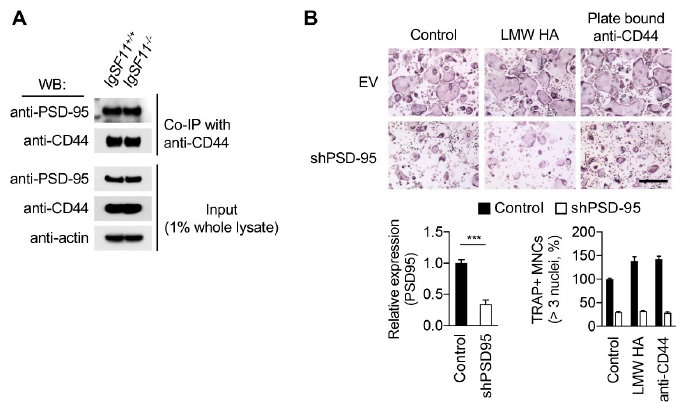
(Co-IP) assay. IgSF11 +/+ and IgSF11 − / − pre-osteoclasts were lysed and the lysates were immunoprecipitated with anti-CD44 antibody. Western blotting (WB) was performed with the indicated antibodies. Input shows amount of proteins in the lysates. ( B ) E ff ect of knockdown of PSD-95 on CD44 stimulation-induced osteoclast di ff erentiation. Wild-type BMMs retrovirally transduced with the indicated shRNAs (EV, empty vector control) were cultured with M-CSF + RANKL in the presence of the indicated stimuli (LMW HA and / or plate bound anti-CD44) for three days. On day three, cells were fixed and stained for TRAP (top). Relative expression of PSD-95 was determined by Q-PCR (bottom left). TRAP + multinucleated cells (three nuclei or more per cell) were counted and the frequency of TRAP + multinucleated cells is shown (bottom right). Scale bars represent 100 µ m. Data are shown as the mean ± S.D. *** p <